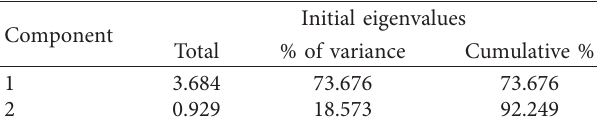
Table 13: The explanatory total variance.